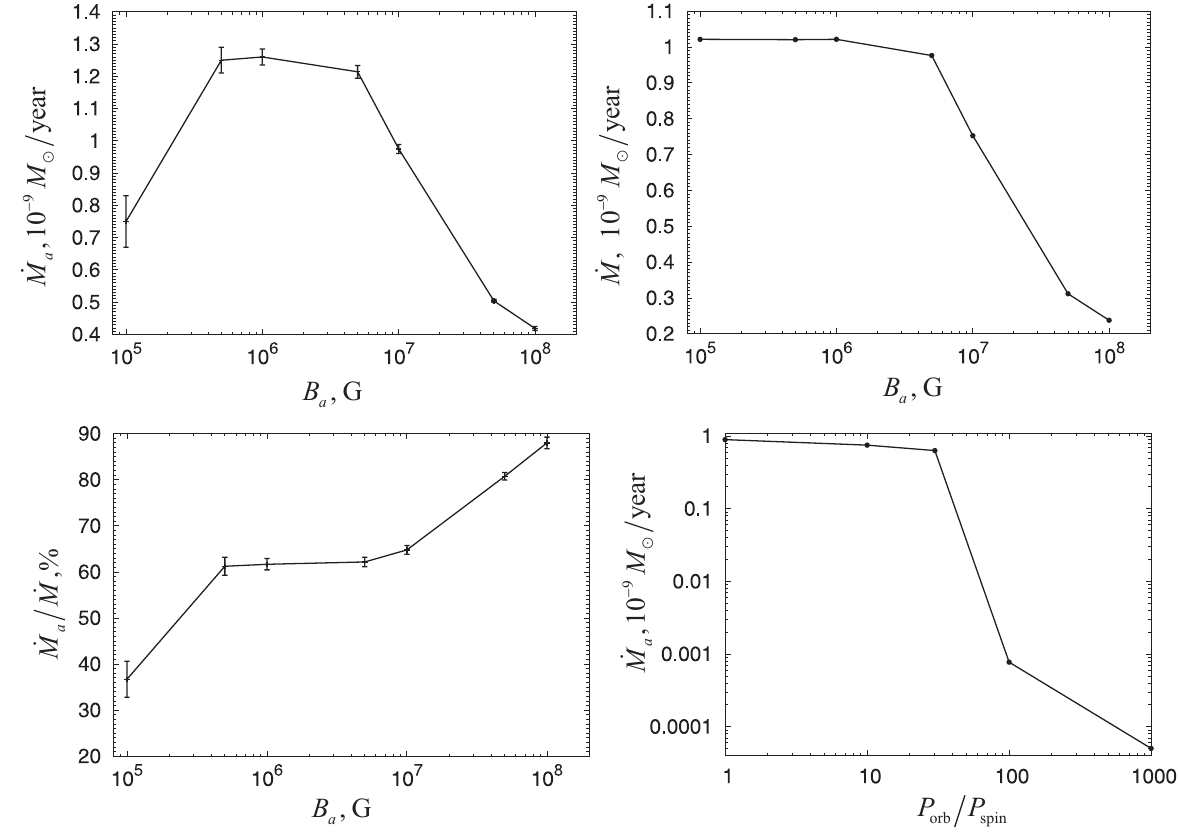
Figure 4: The dependence of the accretion rate ˙ M a on value of the magnetic field B a (left row) in absolute values (top panel) and in % from the mass transfer rate ˙ M (bottom panel). The vertical lines limit the specific amplitudes of the accretion rate variations. In the upper-right panel we show the mass transfer rate as a function of the value of magnetic field. In the lower-right panel we show the mass transfer rate as a function of the accretor’s spin velocity in the model with B a = 10 5